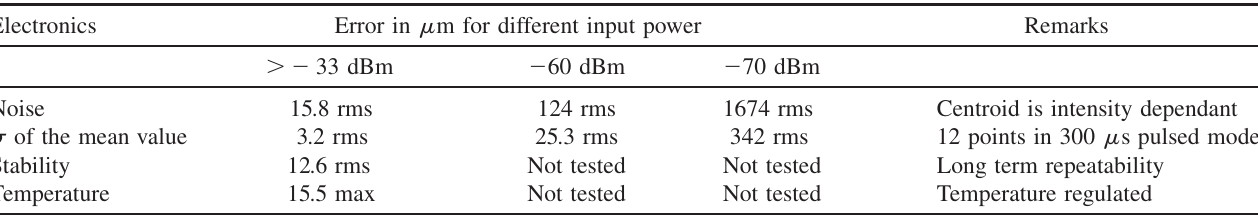
TABLE IV. Performance of the BPM readout electronics.